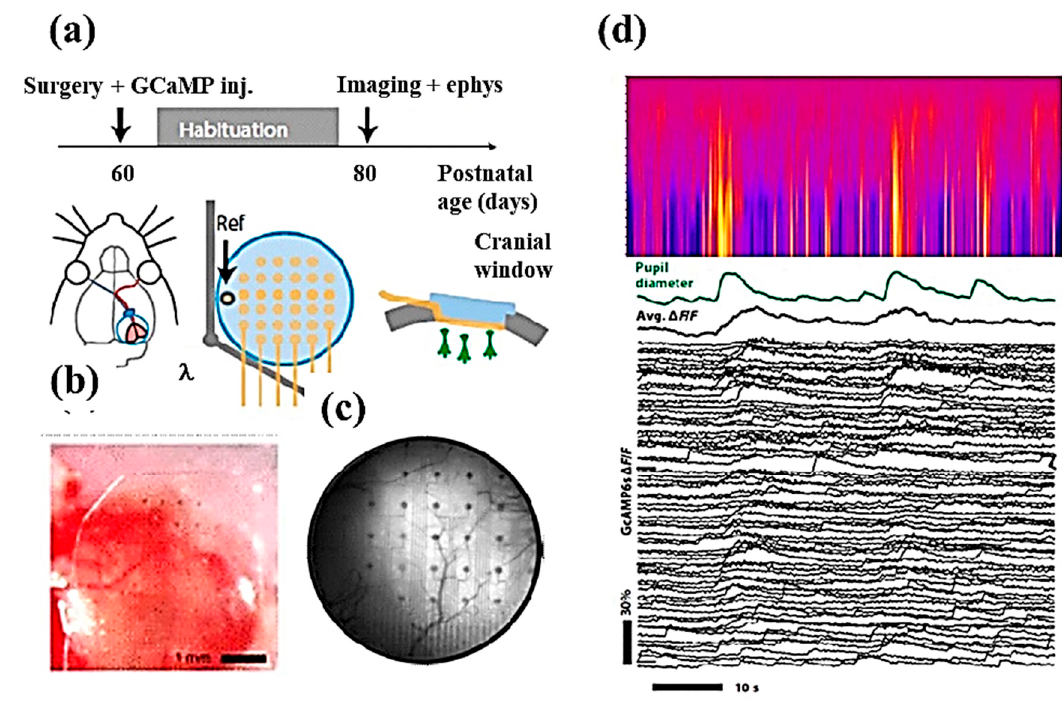
Figure 8. ( a ) Position of multielectrode array (MEA) on the mouse brain and the cranial window. ( b ) Implantation of the MEA in the mouse brain. ( c ) Epifluorescence of the brain and the surrounding areas. ( d ) Simultaneous electrophysiological recording, arousal, and two-photon imaging with single-neuron Ca ++ activity. Reprinted with the permission of [98].